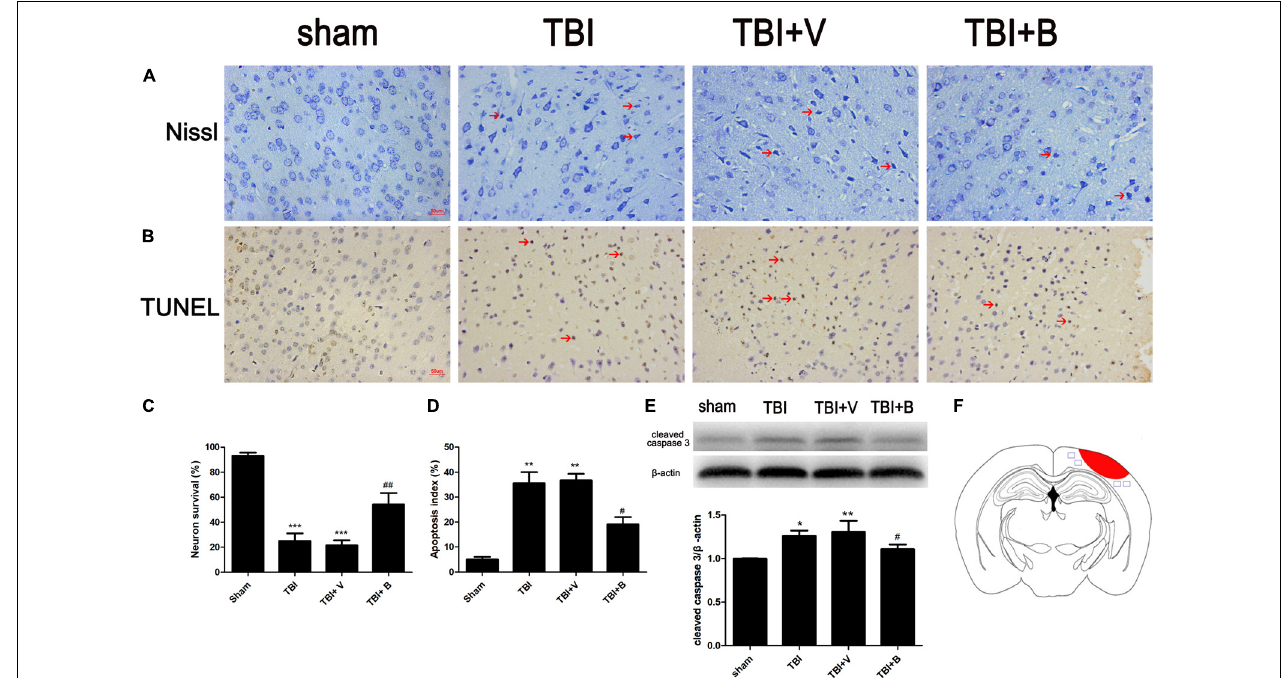
FIGURE 3 | Baicalin suppressed neural apoptosis induced by TBI. (A,C) Representative Nissl staining and the percentage of neuron survival in four groups. The red arrow indicated damaged neurons. (B,D) Representative TUNEL staining and the percentage of apoptotic cells in four groups. The red arrow indicated apoptotic cells. (E) The western blot band and semiquantitative analysis of cleaved caspase-3. (F) A schematic of a brain section after TBI. The area in red refers to injury site and areas in blue refer to regions detected for morphological examination. Data are represented as mean ± SD ( n = 6 per group). ∗ P < 0.05, ∗∗ P < 0.01, and ∗∗∗ P < 0.001 compared with sham group; # P < 0.05 and ## P < 0.01 compared with the TBI + V group. Scale bar: 50 µ